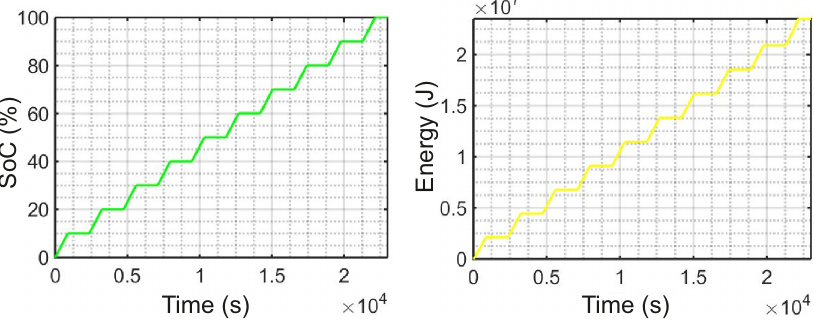
Figure 10. Battery SoC and energy during charging.